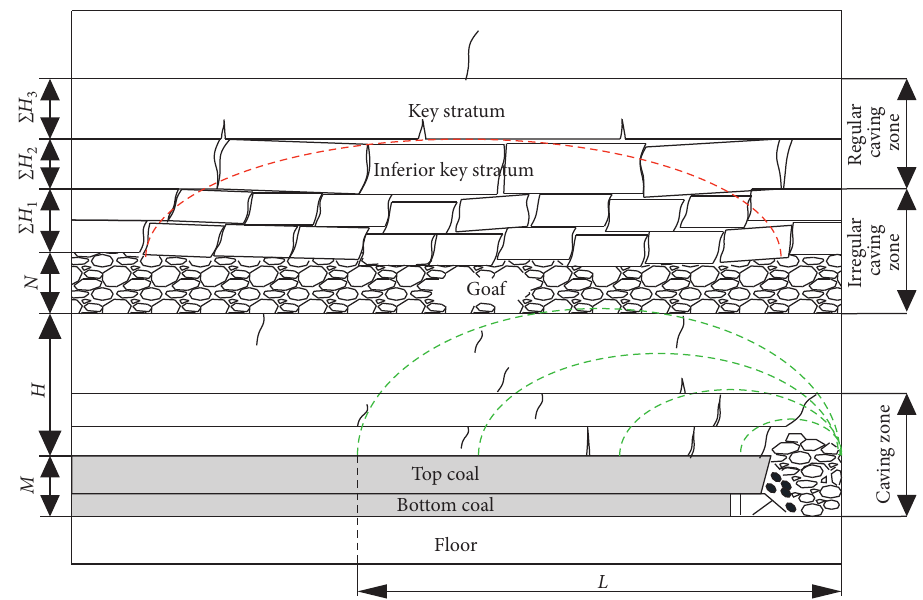
Figure 4: Stability of arch structure under the condition of no interlayer key stratum.